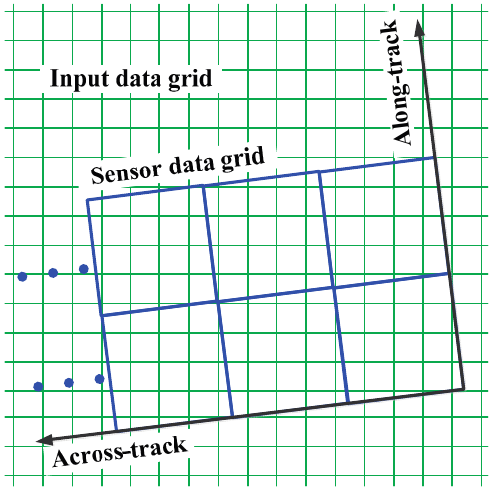
Figure 2. The position relationship between the oversampled input scene and the imaging data. The input scene is the little green grids which are connected by their corner points, and the bigger blue grids are the imaging pixels.